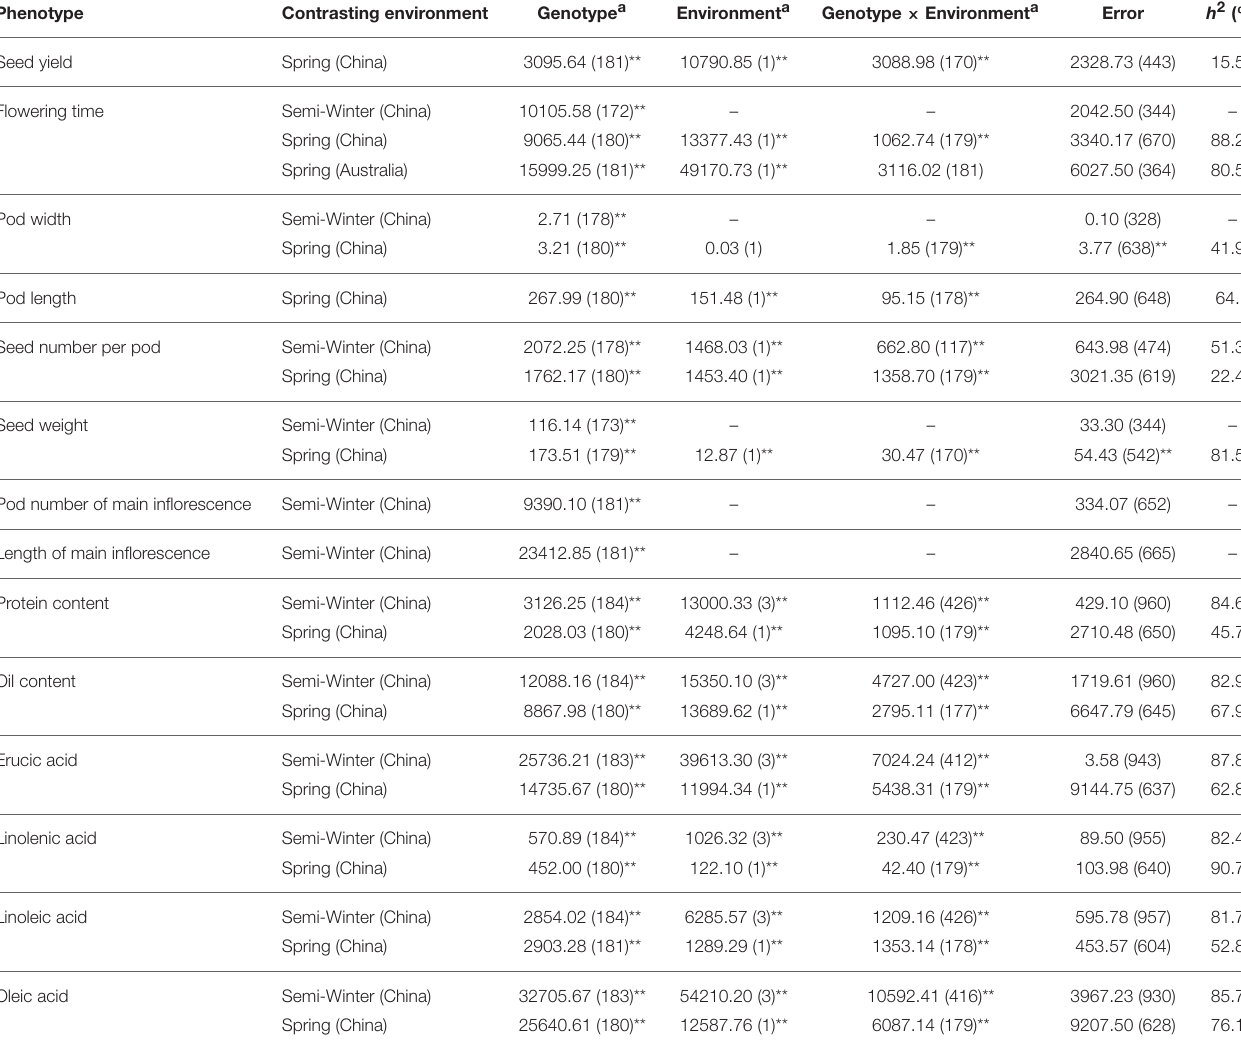
TABLE 3 | AVOVA for the investigated agronomic traits and seed quality traits in YW DH population across